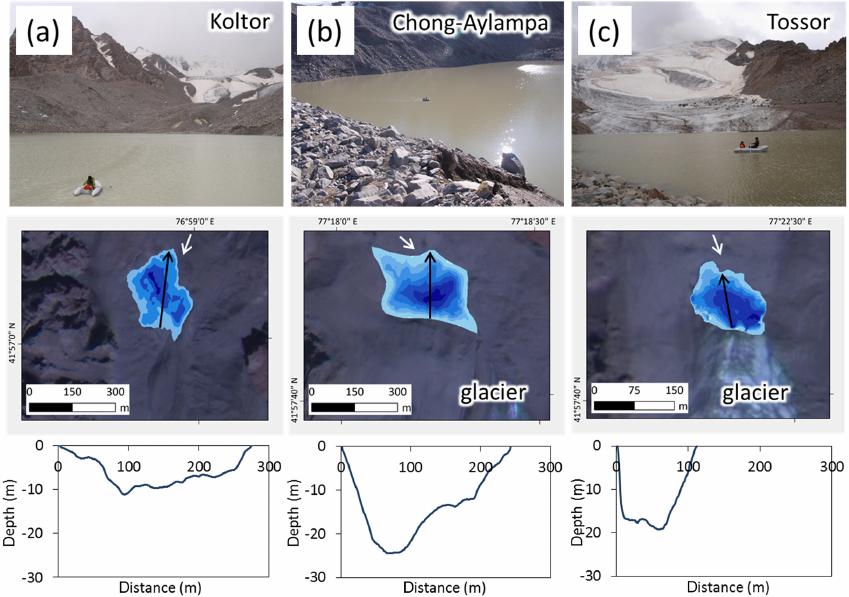
Figure 7. Photos, lake basin maps, and depth profiles of three glacial lakes. (a) Koltor, (b) Chong-Aylampa, (c) Tossor lakes (locations in Fig. 1). Black and white arrows on the lake basin maps show each basin profile line and photo direction, respectively.